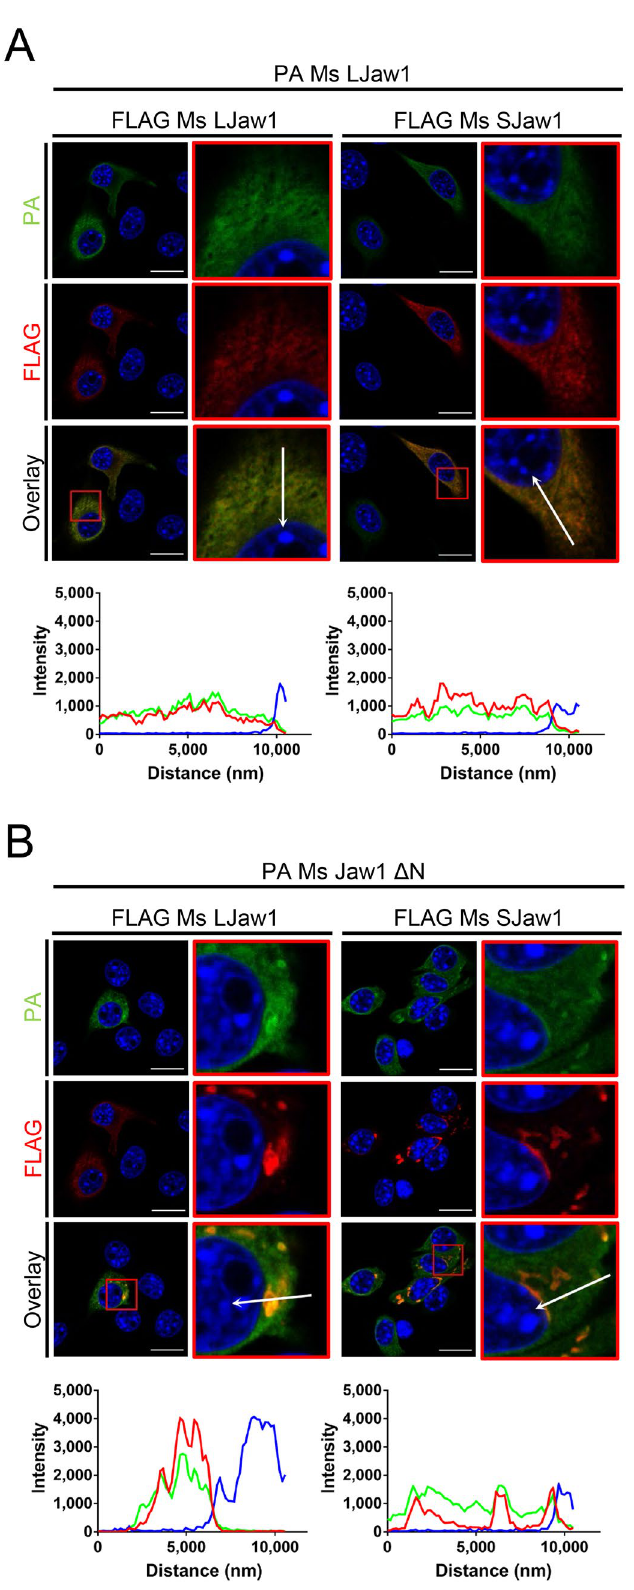
Figure 7. Evaluation of the effects under OSER on the localization of the oligomer. ( A , B ) FLAG Ms LJaw1 or FLAG Ms SJaw1 were co-expressed with PA Ms LJaw1 ( A ) or PA Ms Jaw1 ΔN ( B ) in B16F10 cells by transfection. After incubation for 24 h, immunostaining was performed using an anti-FLAG rabbit antibody and an anti-PA rat antibody. Nuclei were stained with Hoechst33342. The images were acquired by confocal microscopy. Scale bar; 20 μm. The magnified images corresponding to the area surrounded with red lines in each image were generated and line plot profiles were performed along the arrows. Green; PA, red; FLAG, blue; Hoechst